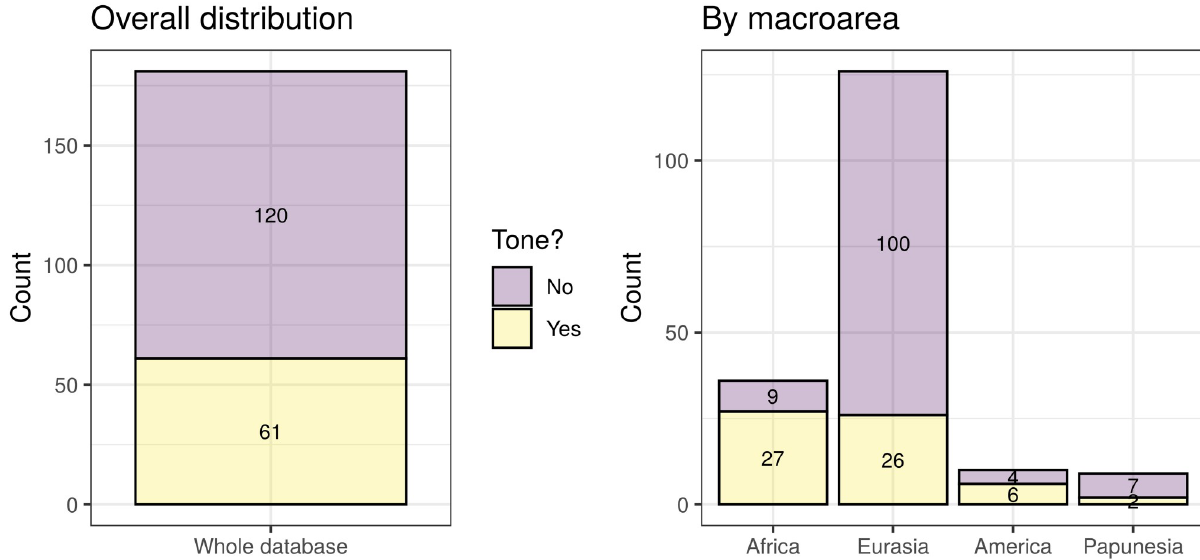
Fig 7. Distribution (as number of languages) of tone1 (no tone vs any type of tone system) across the full database (left) and by macroarea (right). Please note that the vertical axes have different scales to avoid the macroareas with small sample sizes to be visually “squashed” by the whole database.